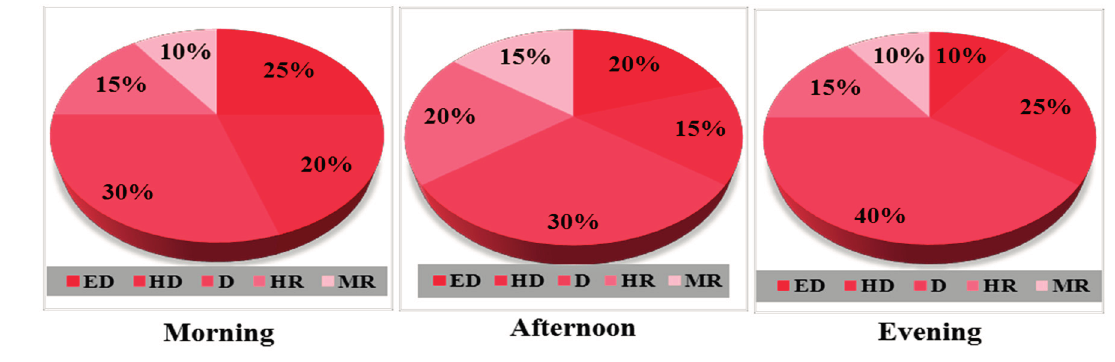
Figure 5. Percentage of noise distribution in Ibadan.